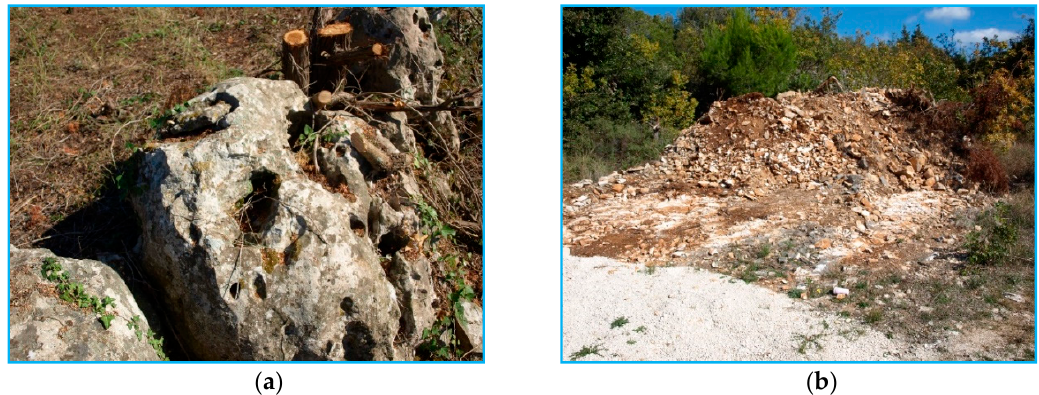
Figure 3. ( a ) Rock mass surface outcrops of karstified thick-bedded to blocky type limestone; ( b ) Surface outcrop of thin-layered clayey limestone identified on the plot.